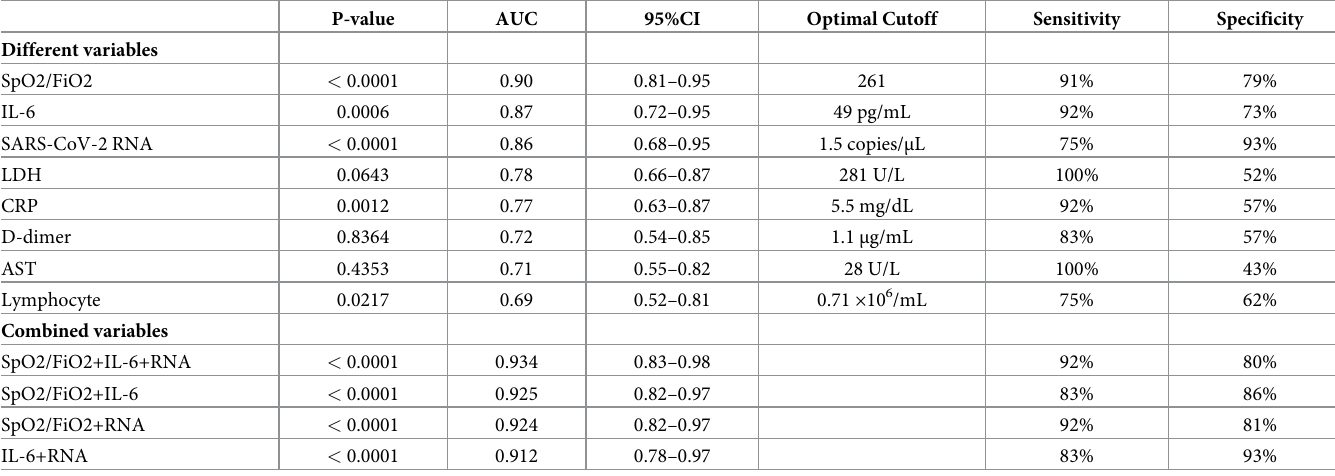
AUC: area under the curve, CI: confidence interval, IL: interleukin, SpO2/FiO2: ratio of oxygen saturation to fraction of inspired oxygen, SARS-CoV-2: severe acute respiratory syndrome-coronavirus 2, CRP: C-reactive protein, AST: aspartate aminotransferase, LDH: lactate dehydrogenase. P-value for fatal